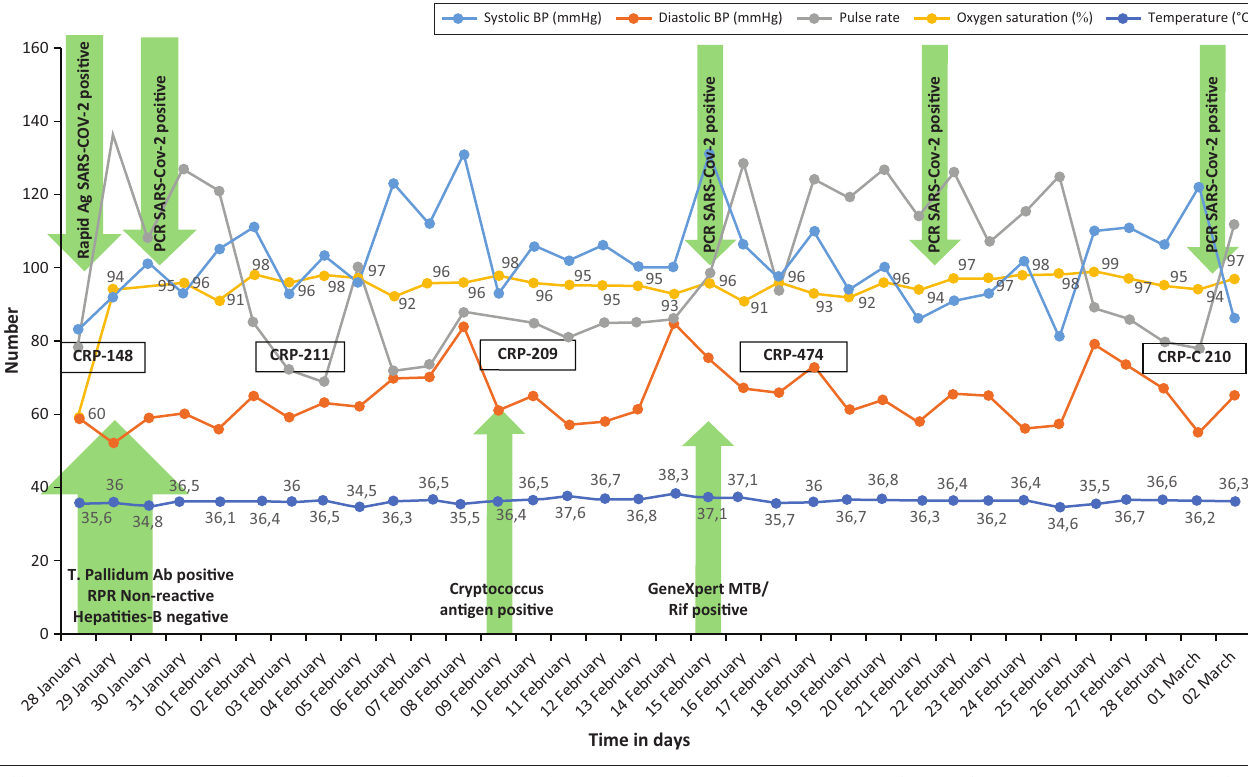
FIGURE 1: Vital sign and laboratory results between 28th January 2021 and 3rd March 2021.